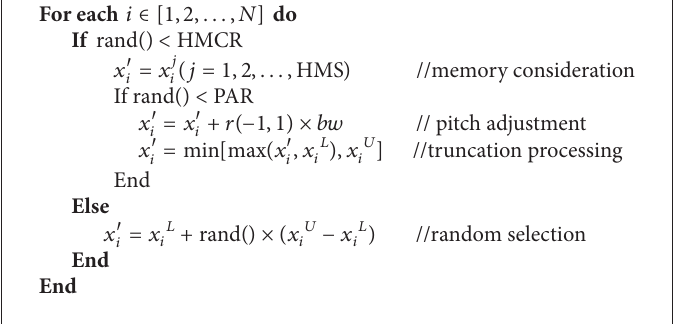
Algorithm 1: Generating a new harmony by classical HS algorithm.